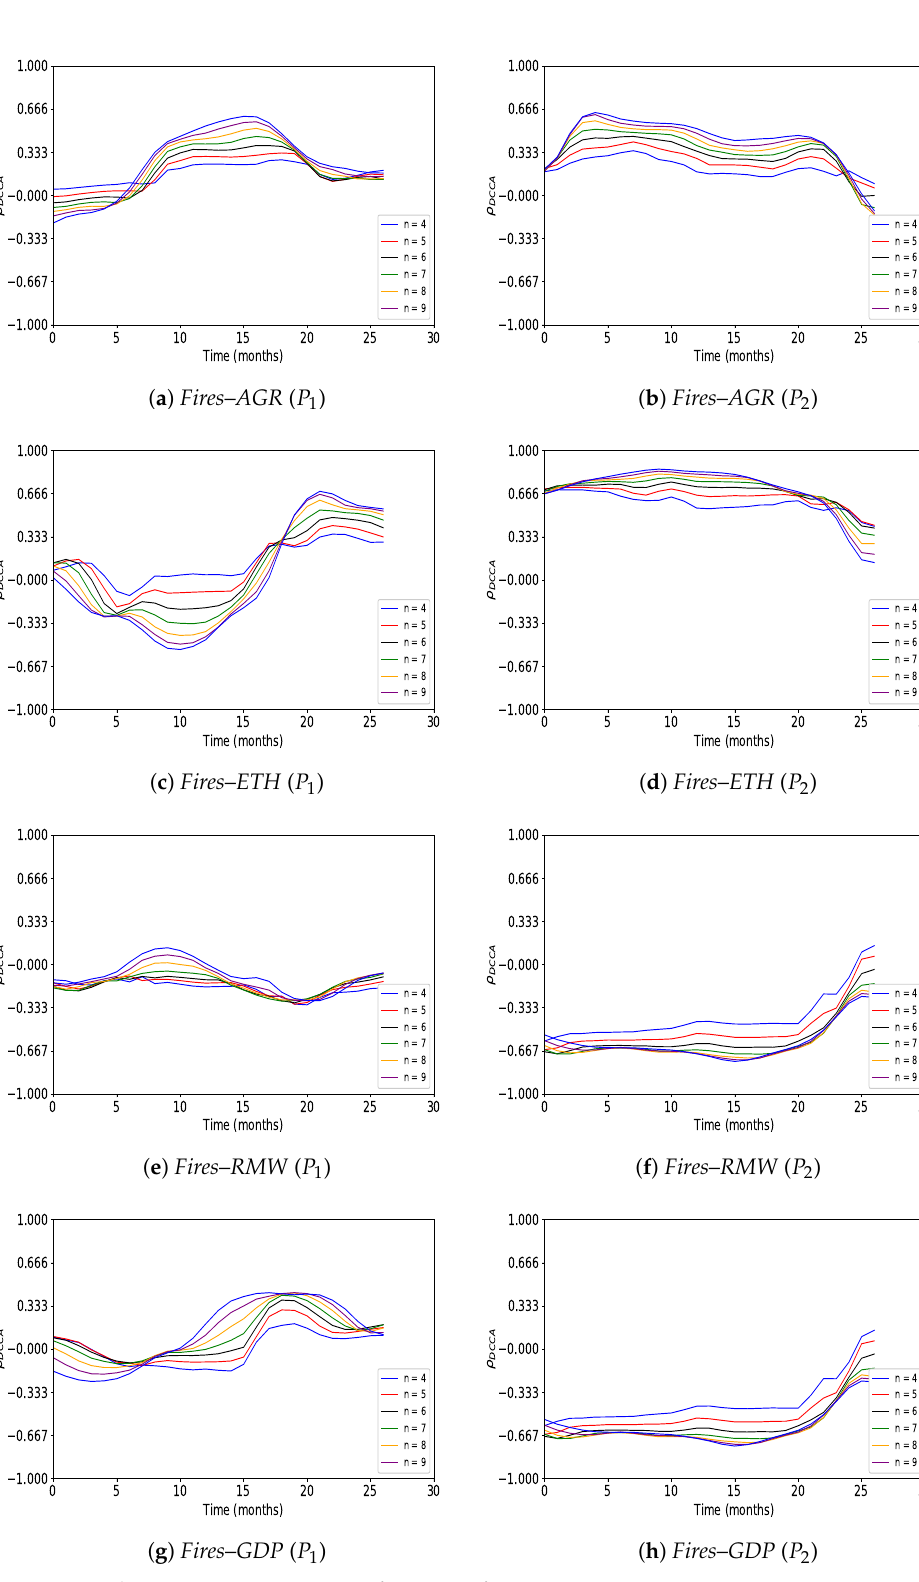
Figure A2. The ρ DCCA comparing TS of P 1 vs. P 2 for